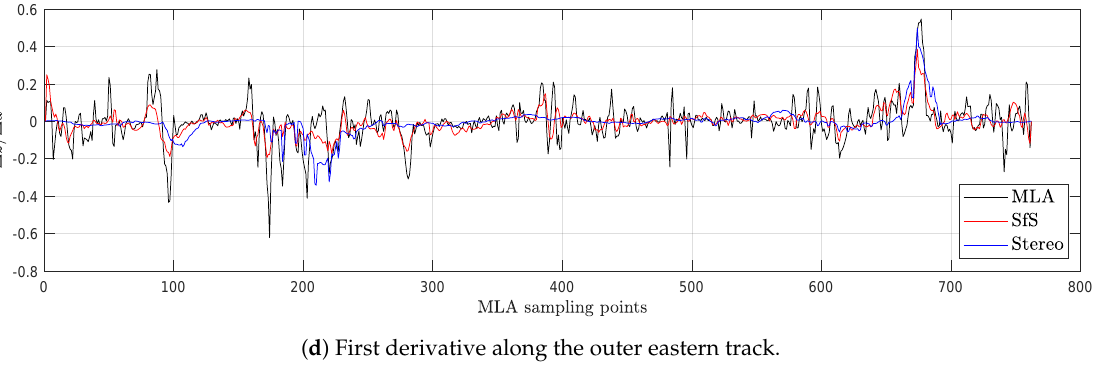
Figure 15. Comparison of the derivative along the MLA tracks (black) to the derivative of the surface constructed by the SfS procedure (red) and the initial stereo DTM (blue) of the Rachmaninoff basin. The positions of the tracks are given in Figure